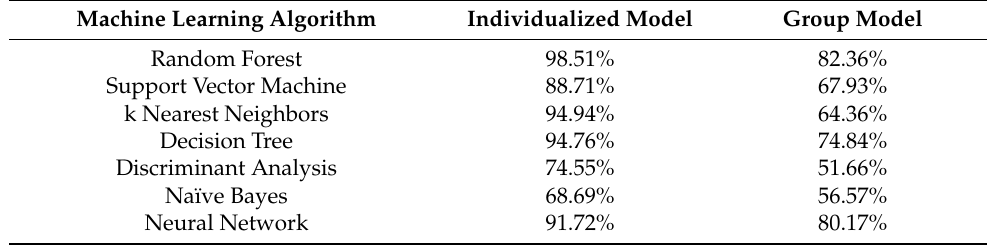
Table 1. Comparison of machine learning algorithms.